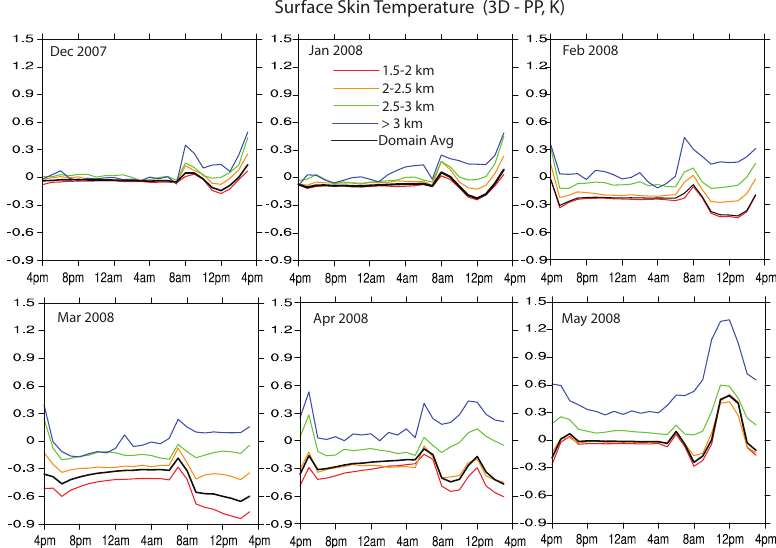
Fig. 8. Same as in Fig. 5, except for the monthly mean domain-averaged diurnal variation time series of surface skin